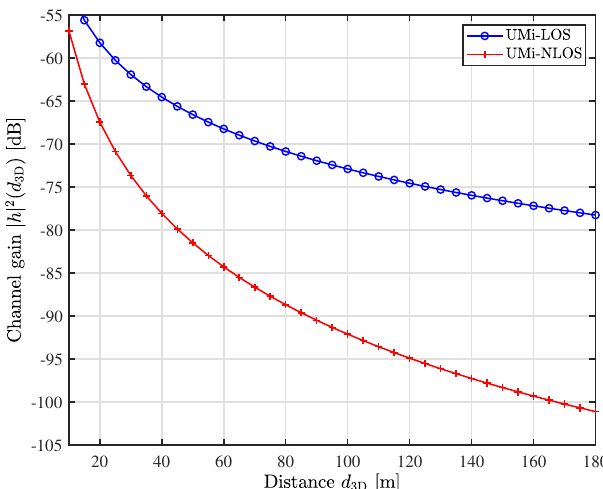
2 with prefect CSI correspond to the distance d Figure 4. Channel gain h 3D with the value | | 10 m 180 m in which the antenna gain G BS and G UE have been fixed to 8 dBi. d 3D ≤ ≤ Table 1. Path loss models for urban micro cell (UMi) when d 2D is less than the break point distance d BP . Distances are in meters, f c is in Hz, and d BS = 10 m ([17], Table 7.4.1-1). = 32.4 + 21log ( d 3D ) + 20log ( f c ) , for 10 m d 2D d BP S PL LOS 10 10 ≤ ≤ O L where d BP = 18 f c / ( 3 10 − 8 ) m for d UE = 1.5 m and d BS = 10 m × = 22.4 + 35.3log ( d 3D ) S PL NLOS = max , where PL (cid:48) PL LOS , PL (cid:48) 10 O NLOS NLOS L (cid:0) (cid:1) N + 21.3log ( f c ) 0.15, for d UT = 1.5 m and 10 m 5 d 2D 10 − ≤ ≤